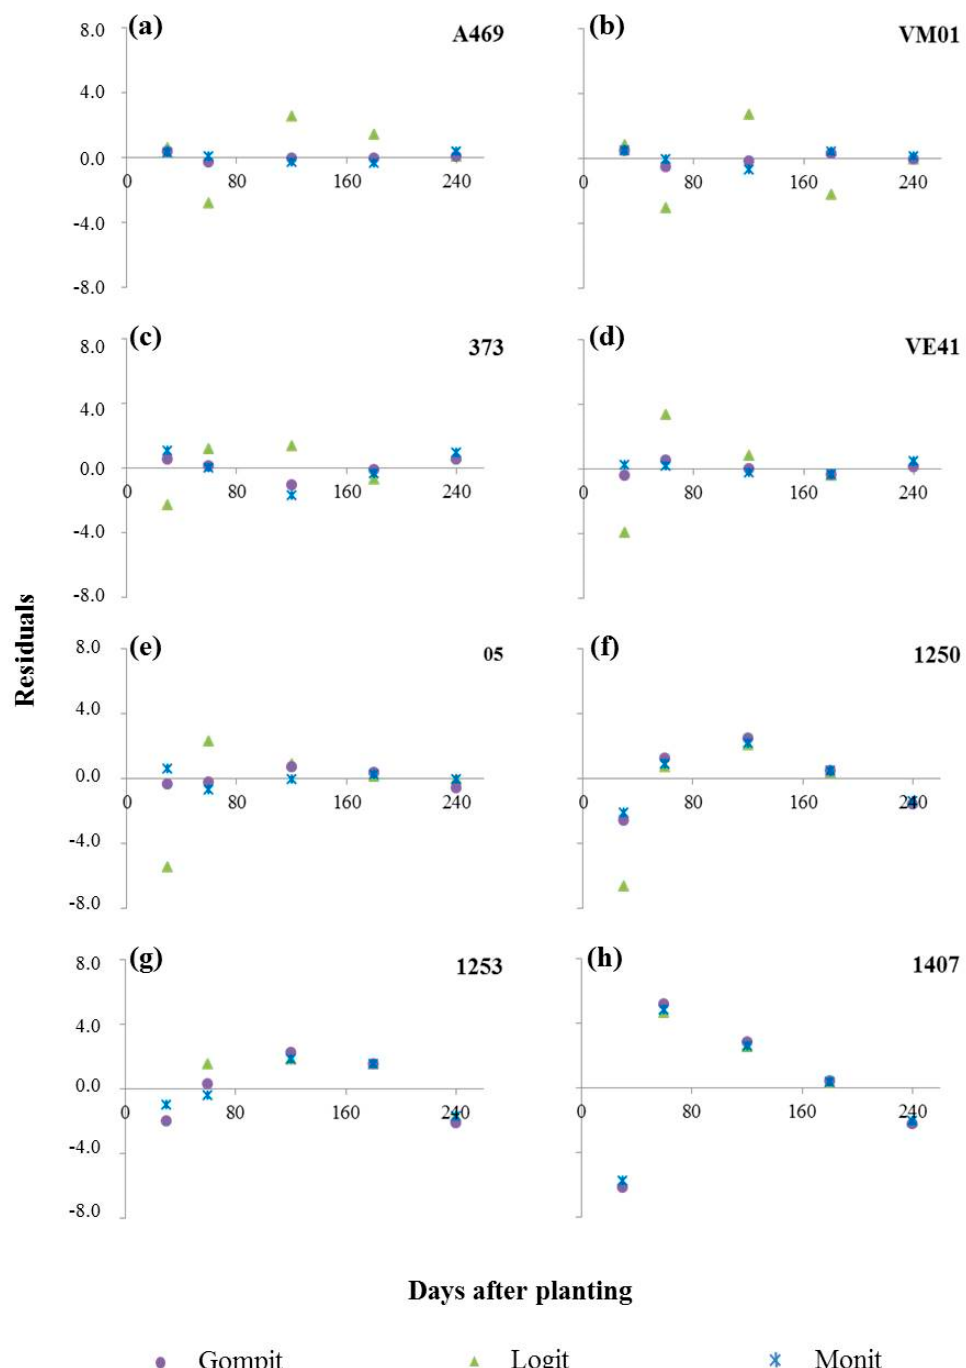
Figure 2. Residual scatterplot of transformed data (Gompit, Logit, and Monit) as a function of time for the Logistic, Gompertz, and Monomolecular models in different eucalyptus clones. ( a ) Clone A49; ( b ) Clone VM01; ( c ) Clone 373; ( d ) Clone VE41; ( e ) Clone 05; ( f ) Clone 1250; ( g ) Clone 1253; ( h ) Clone 1407.